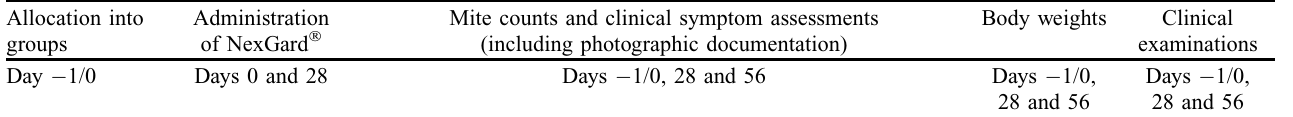
Table 1. Tabulated study